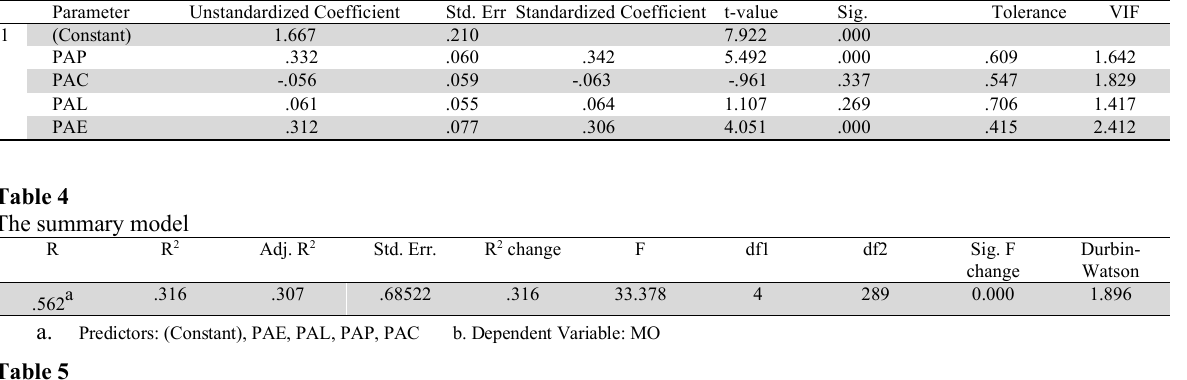
Multiple Regression Coefficient Table Parameter